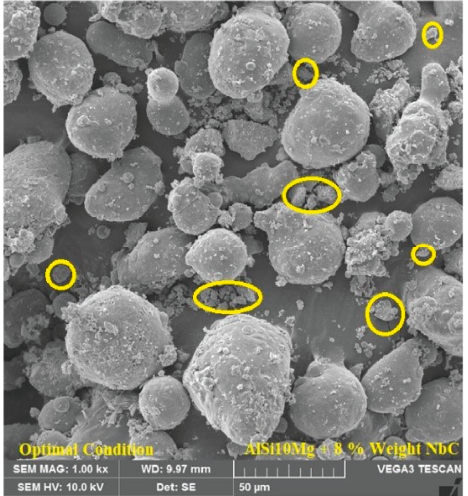
Figure 11: SEM image for the optimum combination of AlSi10Mg +8% weight of NbC.